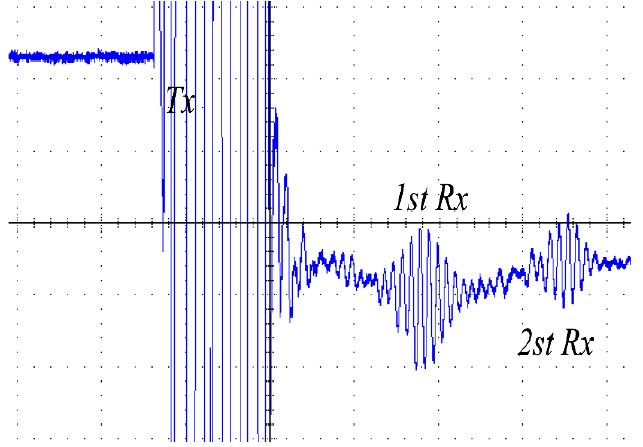
Figure 16. Experimental results of the receiving ultrasonic waveforms (400 nS/div 500 mV/div Rx Vpp = 970 mV).